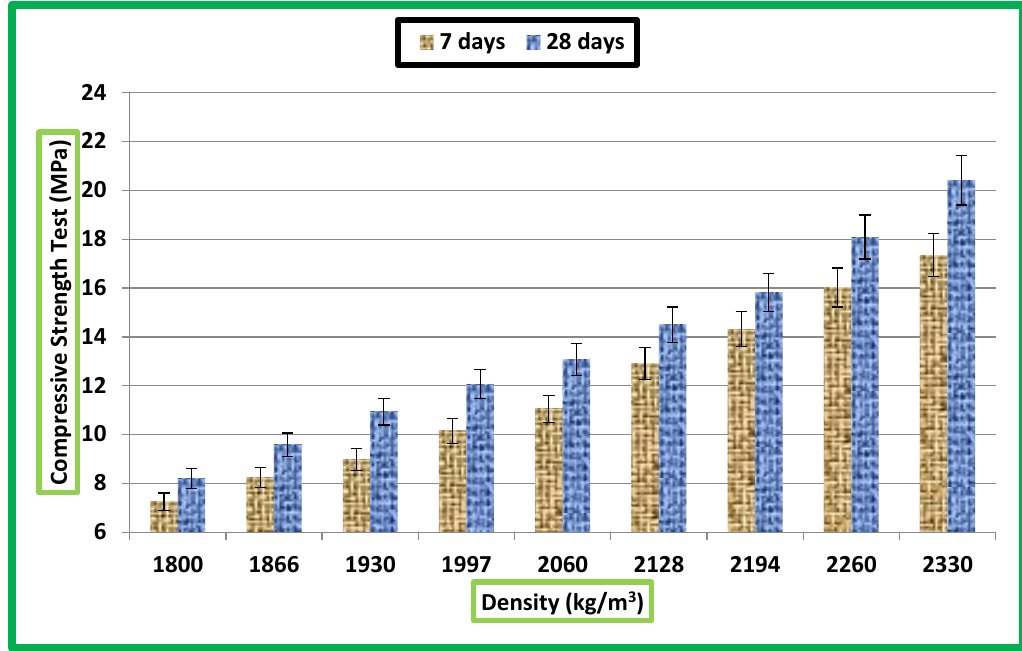
Figure 14. The relationship between density and compressive strength.